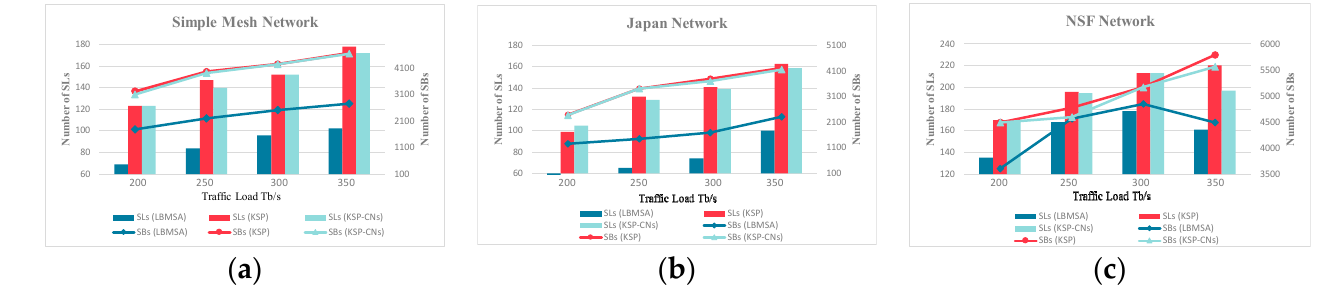
Figure 6. ( a ) The number of occupied SLs and SBs for the different traffic loads in the simple mesh network; ( b ) The number of occupied SLs and SBs for different traffic loads in the Japan network; ( c ) The number of occupied SLs and SBs for different traffic loads in the NSF network.